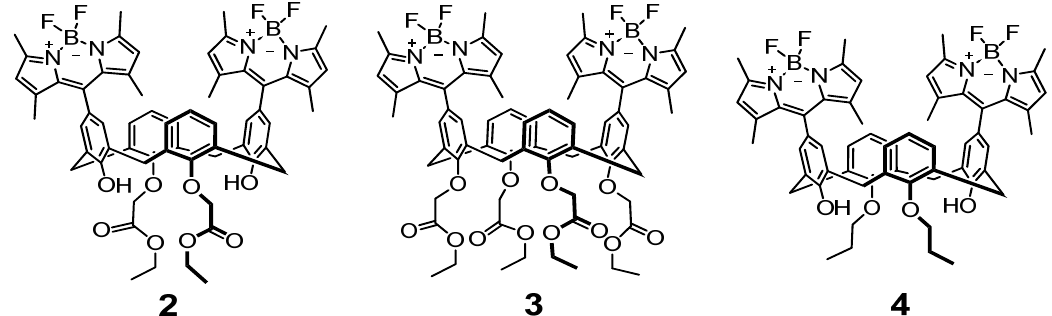
Figure 4. Chemical structures of calix[4]arene-based chemosensors 2–4 for Ca 2+ .